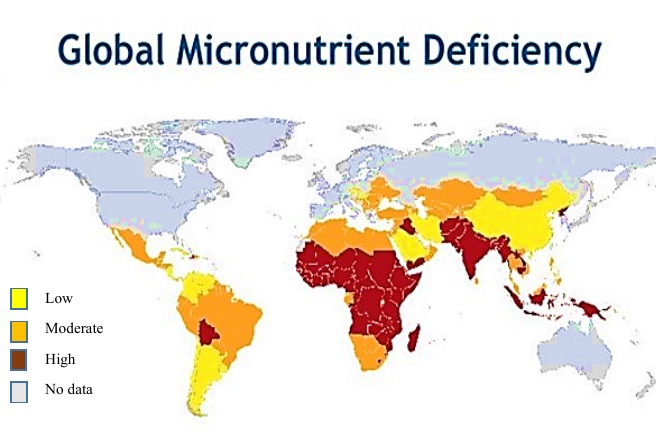
Fig. 1 Most common micronutrients deficiency status in the world. Data source: WHO children under 5 years of age prevalence data. Severity was calculated using a weighting system based on levels of publishing health significance cut-offs (low, moderate, and high). Sources: [27,38].